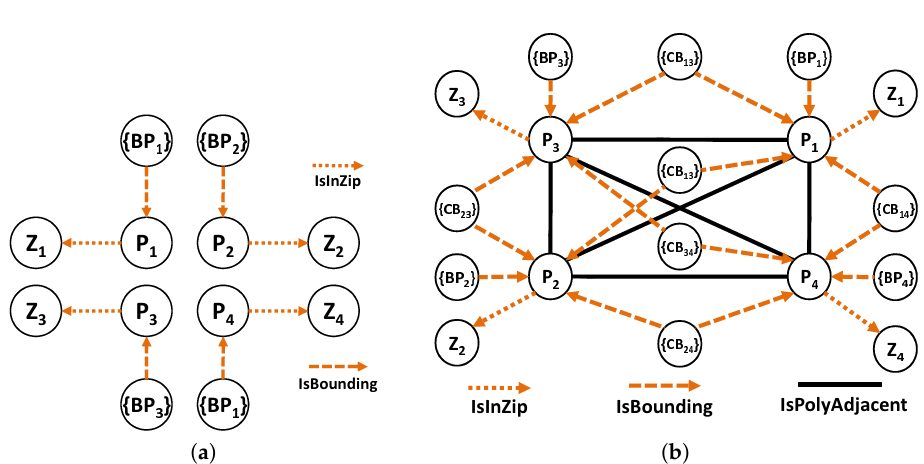
Figure 8. Building ZIP codes—Steps 2.2 and 3. ( a ) Step 2.2; ( b ) Step 3.